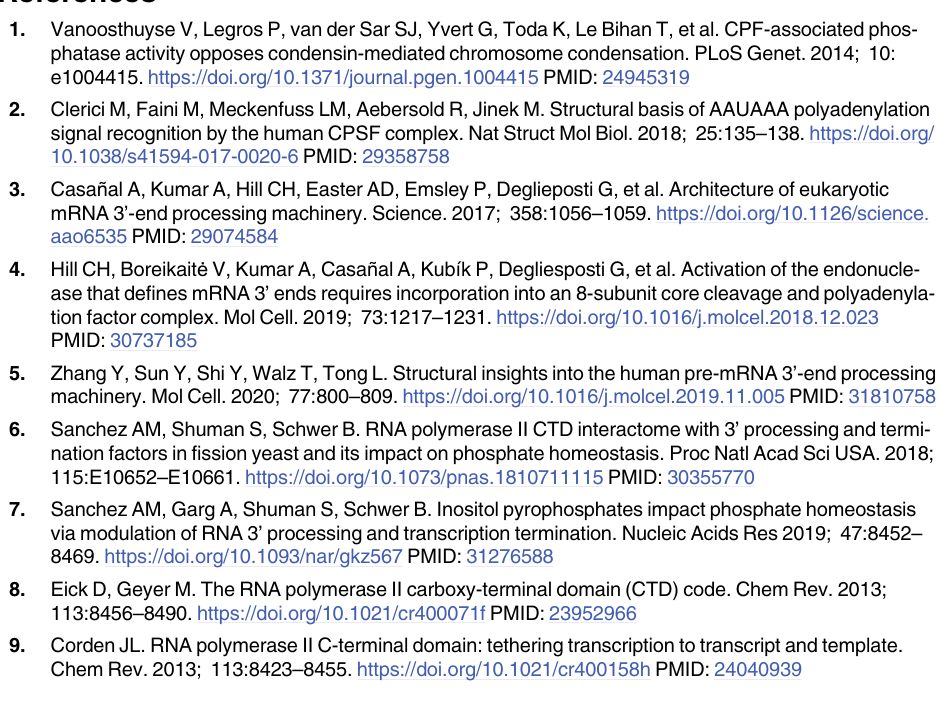
S9 Fig. Dis2 mutations that affect interaction with Ppn1. Gal4 BD fusions to full-length Dis2 alanine mutants and the C-terminal deletion mutant Dis2-(1–304) were tested for 2-hybrid interactions with full-length Ppn1 fused to the Gal4 AD. BD/AD pairs that scored positive in both reporter assays (LacZ expression and histidine prototrophy) are indicated as + +. Pairs that were negative in both reporter assays are scored as—. Weakly positive pairs are scored as ±± . S1 Table. Fission yeast strains used in this